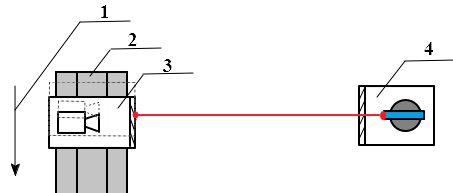
Figure 9. Sketch map of the principle verification experiment. 1. moving direction; 2. micro motion platform; 3. image acquisition module; 4. laser transmitter module.